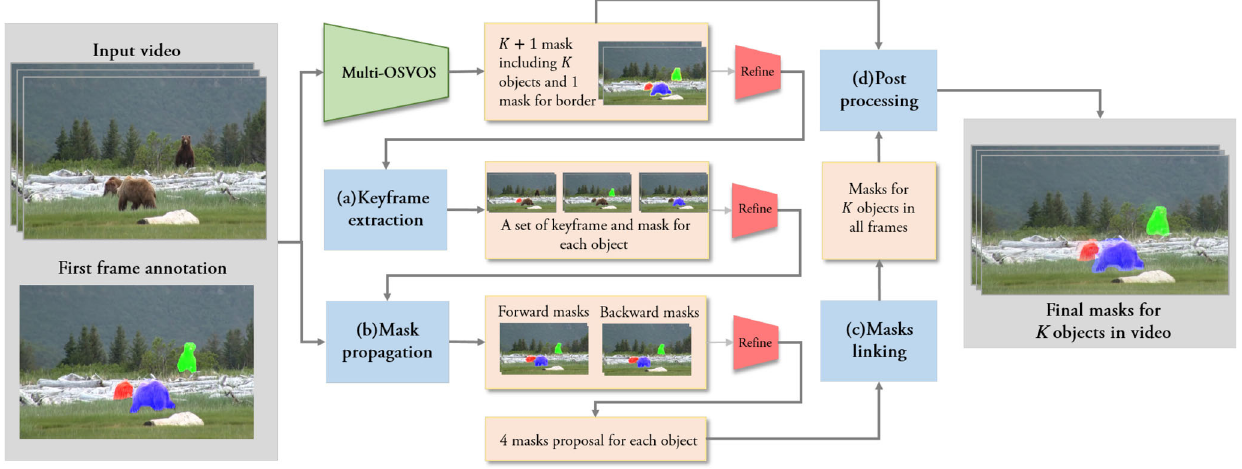
Fig. 1 General pipeline of our object segmentation method. Given the input video and annotations in the first frame, our algorithm alternates two CNN-based semantic segmentation steps (multi-OSVOS network in green, refining network in red) with 4 video-tracking steps (blue blocks):